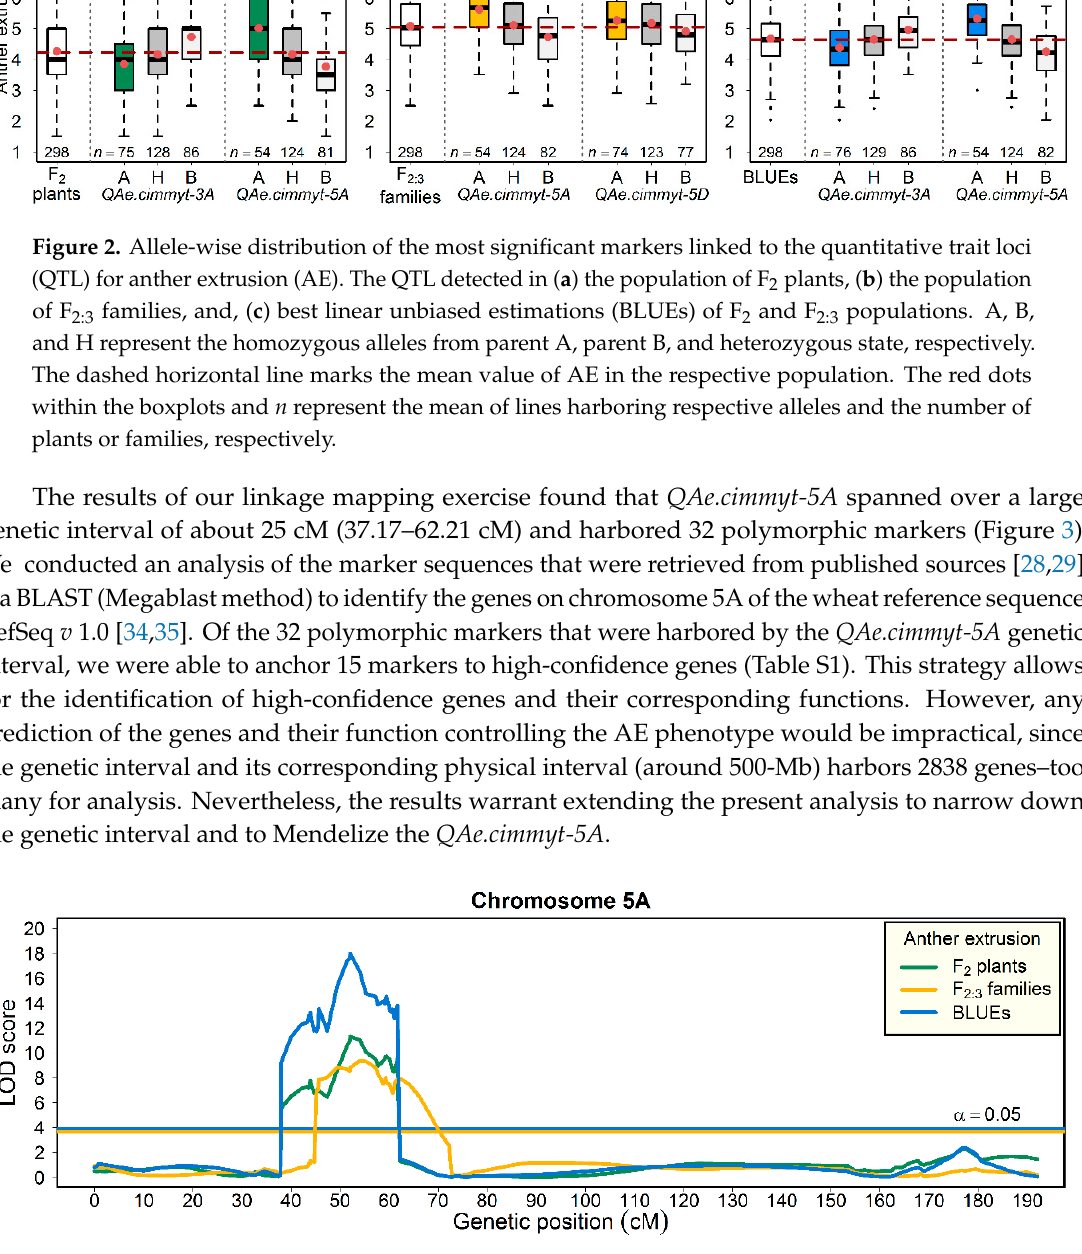
Figure 3. Linkage map of chromosome 5A harboring large-effect QTL ( QAe.cimmyt-5A ) for anther extrusion identified in F 2 and F 2:3 generations, and their best linear unbiased estimations (BLUEs). The color code of the identified QTL in different generations is given in the figure. The α -value denotes the logarithm of the odds (LOD) threshold to declare the presence of QTL.